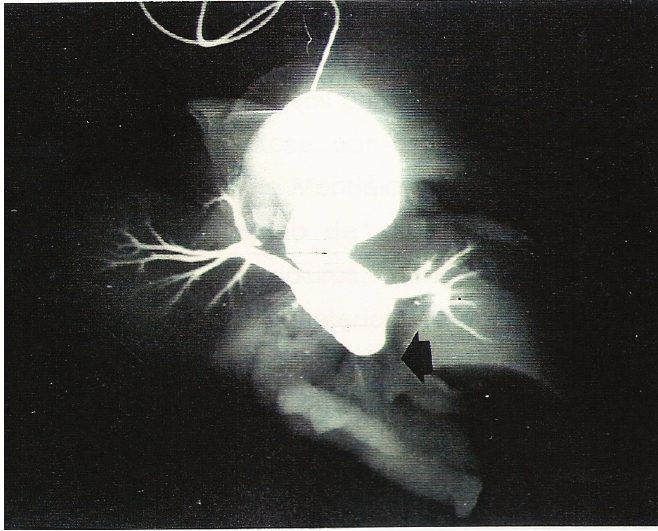
FIGURE 3 - Cholangiography revealed a pattern of complete biliary obstruction in the bile duct, still tied after 30 days.